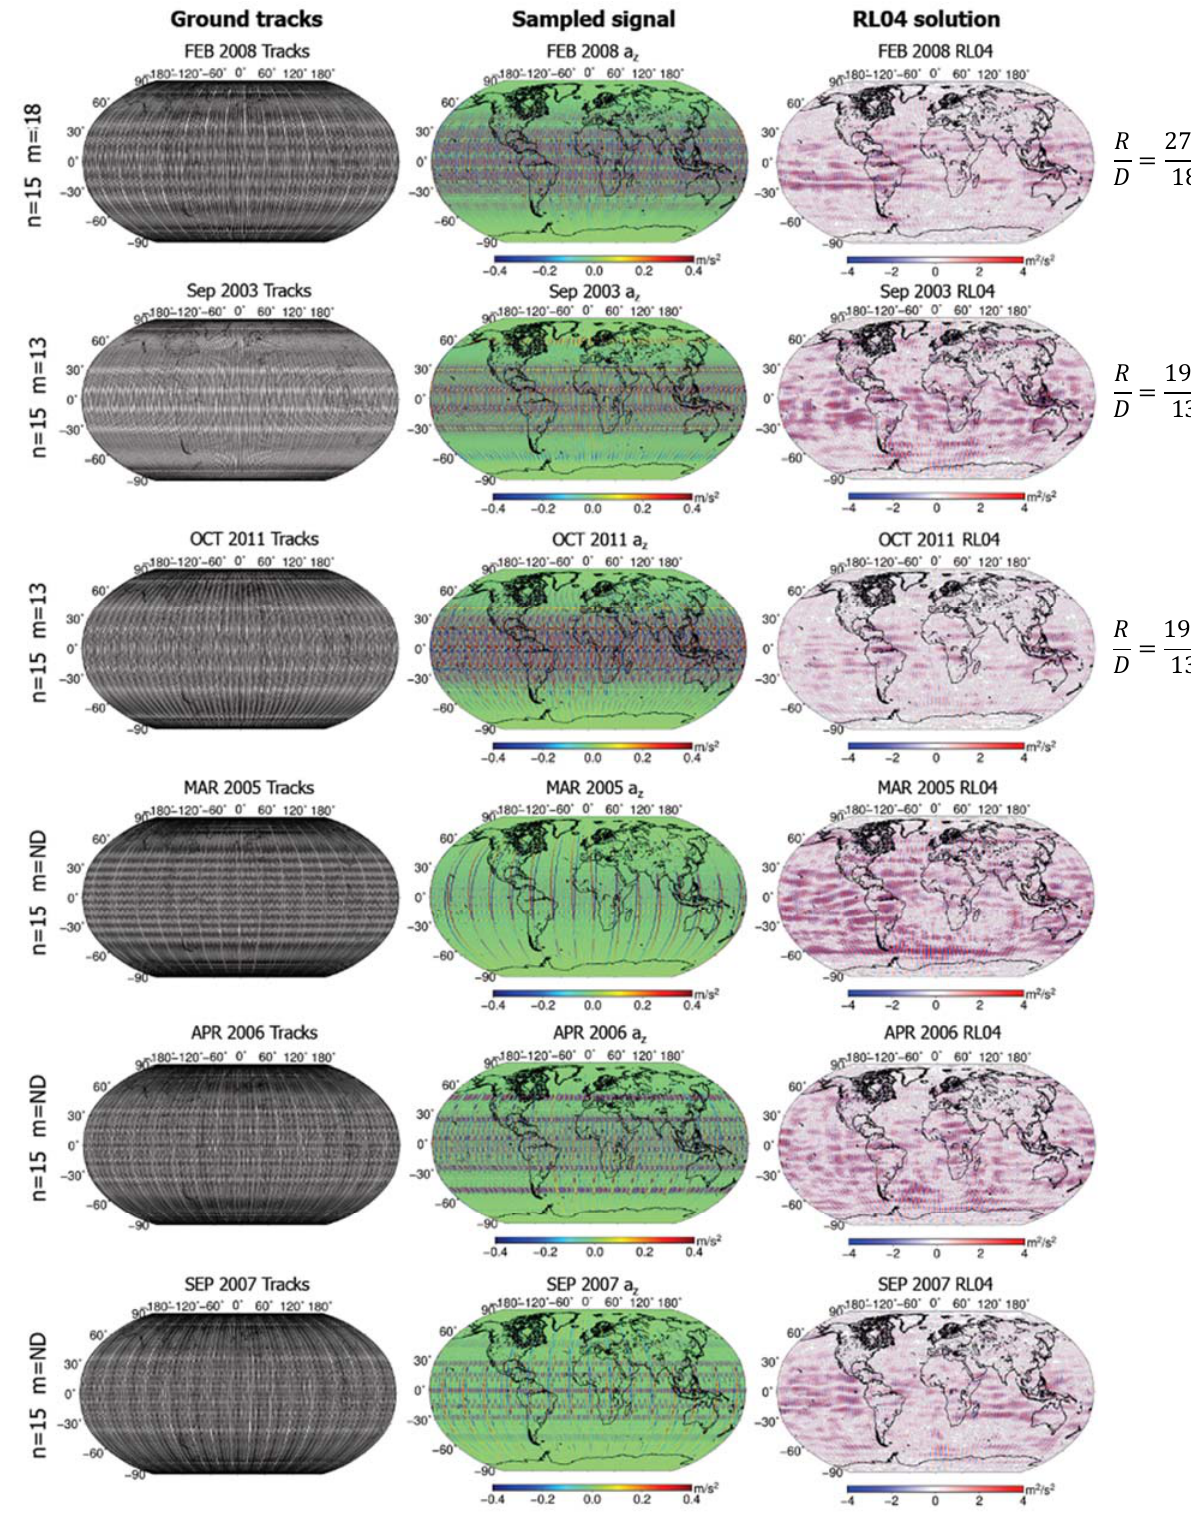
Figure 9. Left Panels: Ground tracks during various months when m is either not defined or its value is outside the sub-Nyquist region; Middle Panels: Difference between GRACE-A and GRACE-B total accelerations derived from the precise orbits (POD) of the two spacecraft along the z -axis. We note that the ratio m / n does not satisfy the condition 1 < m < 1 . In such cases the stripes are obliterated. Right panels: GRACE RL04 gravitational potential (not available after 2012). R / D ratios agree with ([20], Figure 6).